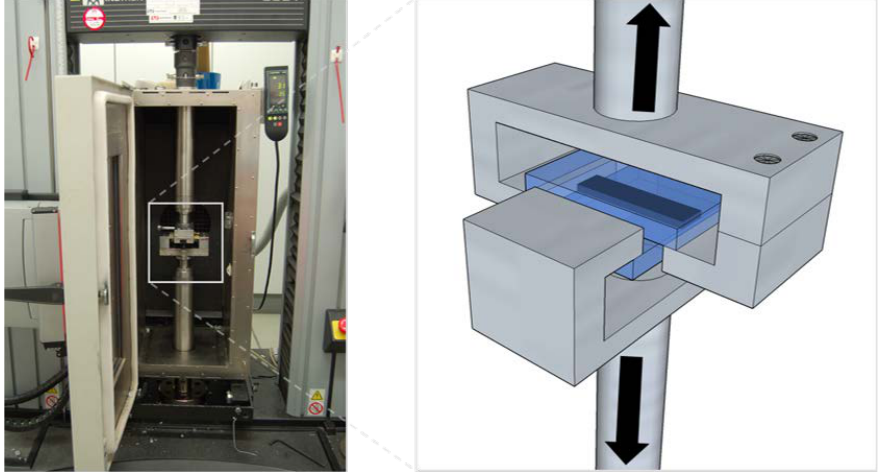
Figure 5: Specimens during tensile tests in the Instron 5880 (Popp